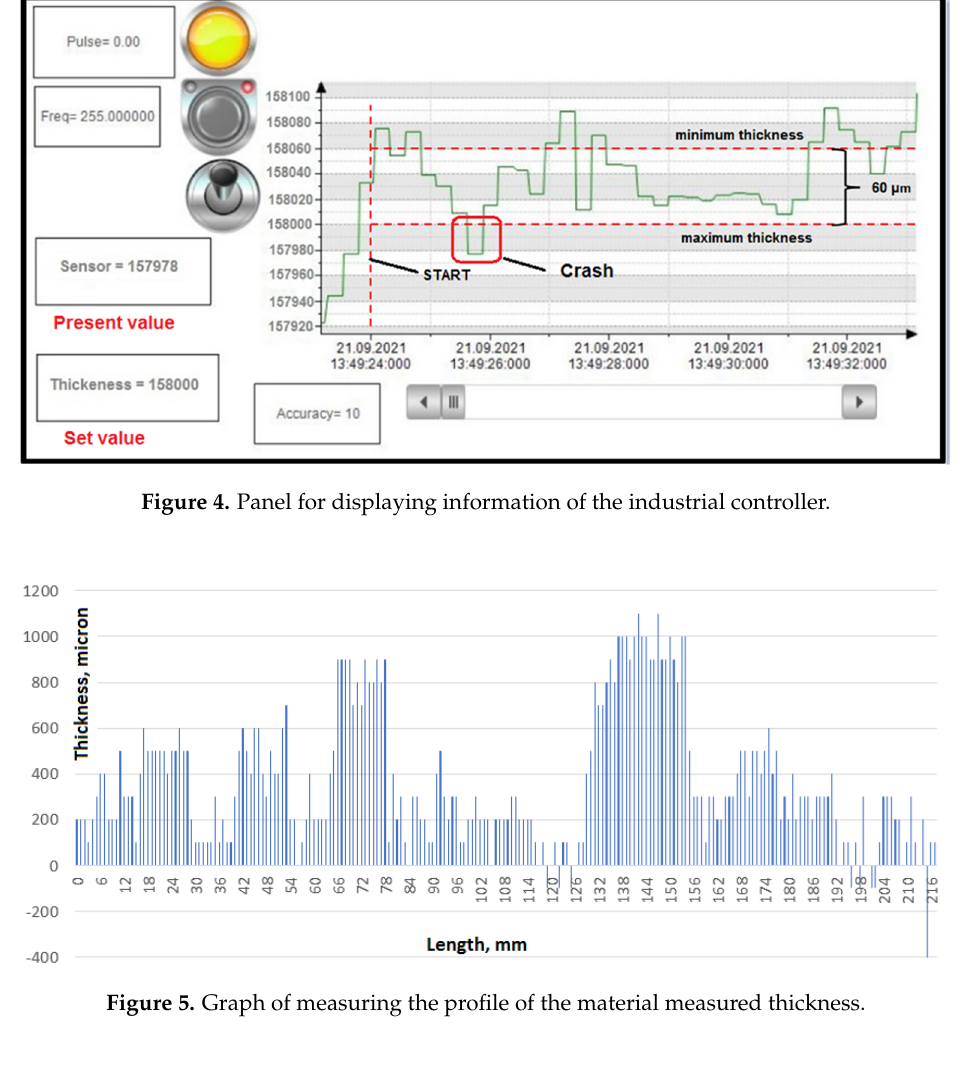
Figure 5. Graph of measuring the profile of the material measured thickness.